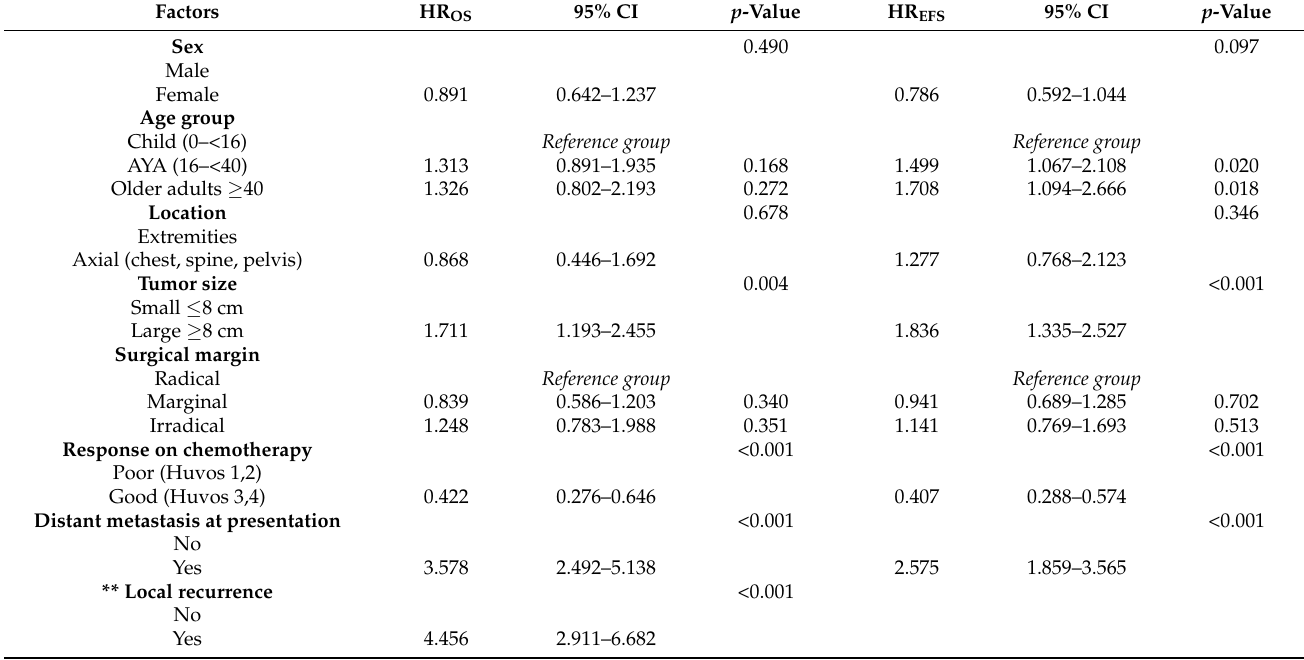
Table 4. Hazard ratio for prognostic factors on OS and EFS along with the 95% confidence interval estimated with the Cox proportional hazards regression model.